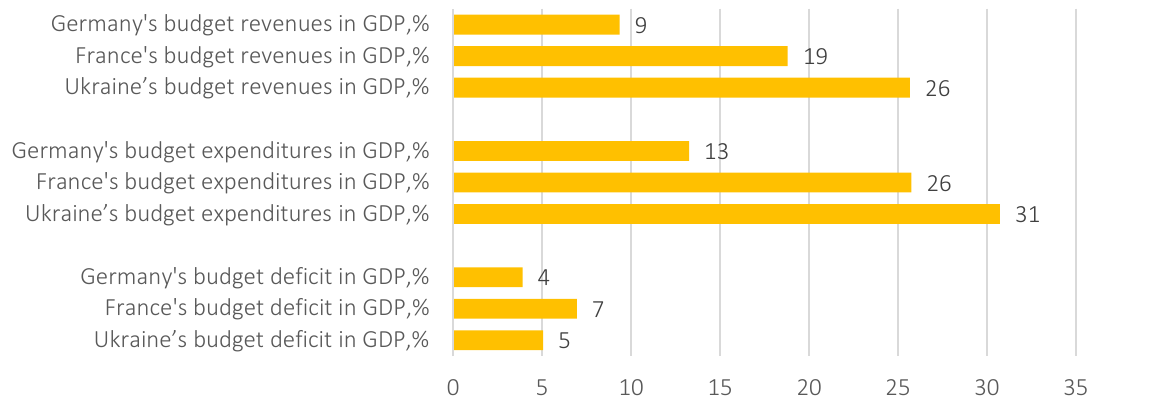
Figure 5. The share of revenues, expenditures, and budget deficits of France, Germany, and Ukraine in GDP in 2020,